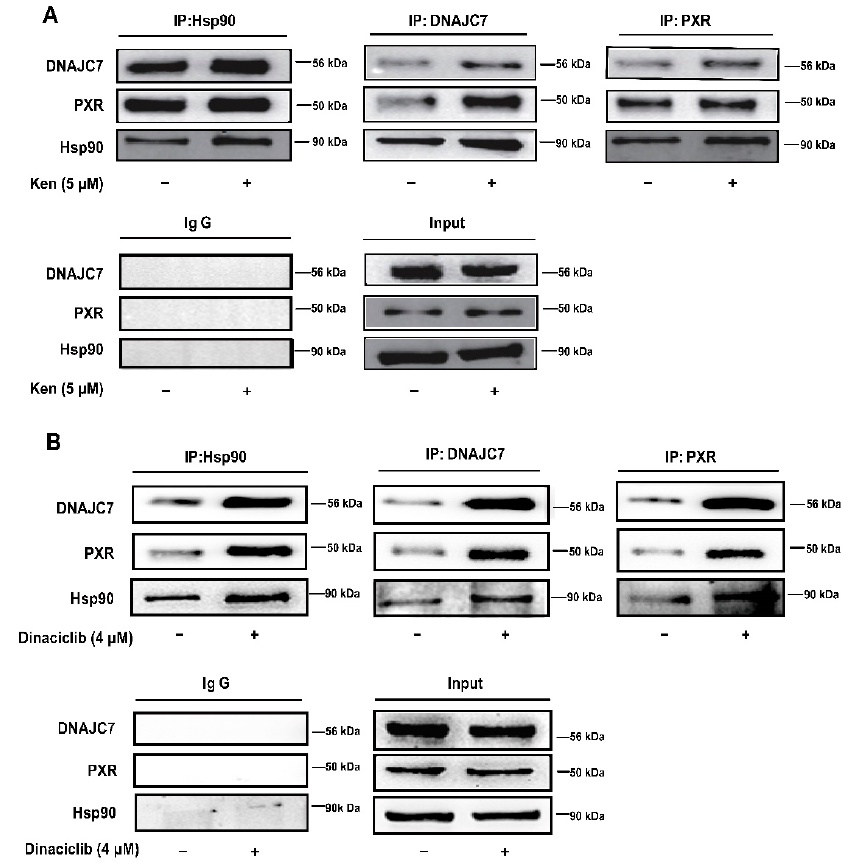
Figure 3. The CDK inhibitors increase the interaction between PXR, DNAJC7 and Hsp90. HepG2 cells were treated with kenpaullone (5 μ M) ( A ) or dinaciclib (4 μ M) ( B ) for 24 h, and the interactions of PXR with DNAJC7 and Hsp90 were investigated by co-immunoprecipitation. Cell lysates were immunoprecipitated with anti-PXR antibody, anti-Hsp90 antibody or anti-DNAJC7 antibody, fol- lowed by immunoblotting with anti-PXR antibody, anti-Hsp90 antibody or anti-DNAJC7 antibody, respectively. Experiments described in this figure were repeated independently at least three times.